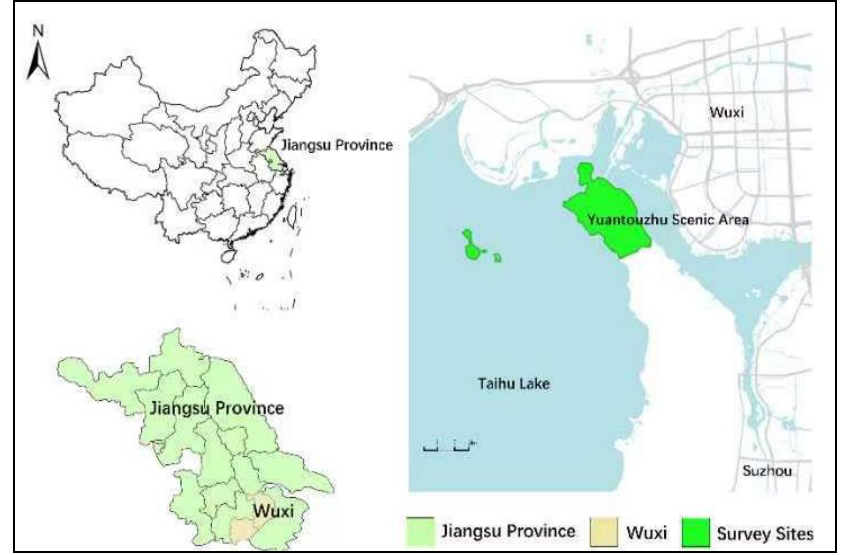
Figure 1. Location of the study